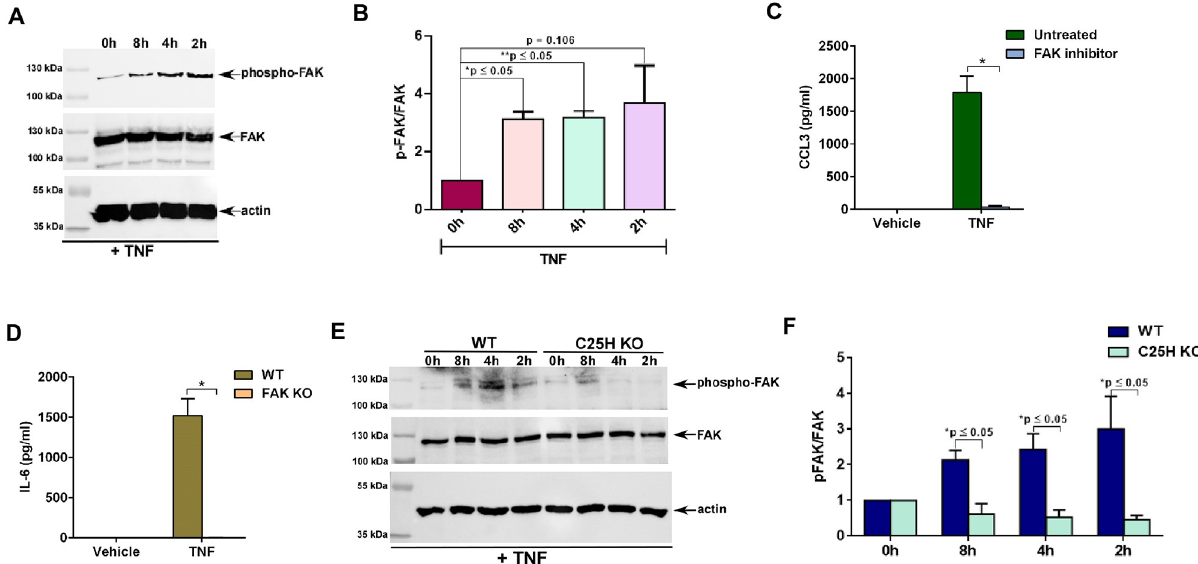
Fig 3. 25HC produced by TNF activates FAK and FAK activation is required for optimal TNF-mediated pro-inflammatory response and NF κ B activation. (A) Cell lysate from THP-1 macrophages treated with 100ng/ml of TNF for the indicated time points were subjected to western blot to detect status of phosphorylated FAK (phospho-FAK). The immunoblot is representative of three independent experiments with similar results. (B) Densitometric analysis of the western blot presented in Fig 3a. The densitometric quantification values for phospho-FAK immunoblot represent the ratio of phospho-FAK:FAK and the fold-induction was calculated after normalizing with the control 0h group. (C) Medium supernatant collected from RAW264.7 macrophages treated with TNF for 8h in the presence or absence (untreated vehicle control) of FAK inhibitor (5 μ M) was analyzed for CCL3 production by ELISA (n = 12; three independent experiments). (D) Medium supernatant collected from WT and FAK KO MEFs treated with TNF (10ng/ml;16h) was analyzed for IL-6 production by ELISA (n = 9; three independent experiments). (E) Cell lysate from WT and C25H KO BMDMs treated with TNF (100ng/ml) for the indicated time points were subjected to western blot to detect status of phosphorylated FAK (phospho-FAK). The immunoblot is representative of four independent experiments with similar results. (F) Densitometric analysis of the western blot presented in Fig 3e. The densitometric quantification values for phospho-FAK immunoblot represent the ratio of phospho-FAK:FAK and the fold-induction was calculated after normalizing with the control 0h group. ELISA data are shown as Mean ± SEM. � p � 0.05 using a Student’s t-test. The densitometric values represent the mean ± SEM from four independent experiments. The p value shown in the figure was calculated using a Student’s t-test ( � p and �� p � 0.05).